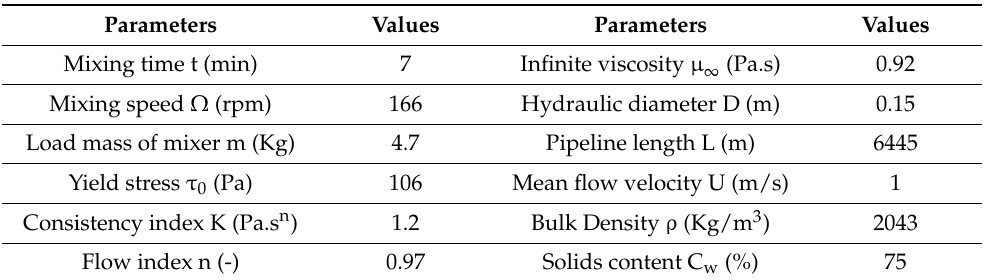
Table 2. Data used to determine the linear pressure drops and the specific energy dissipated during the transport of the CPB-T1 mixture M02.